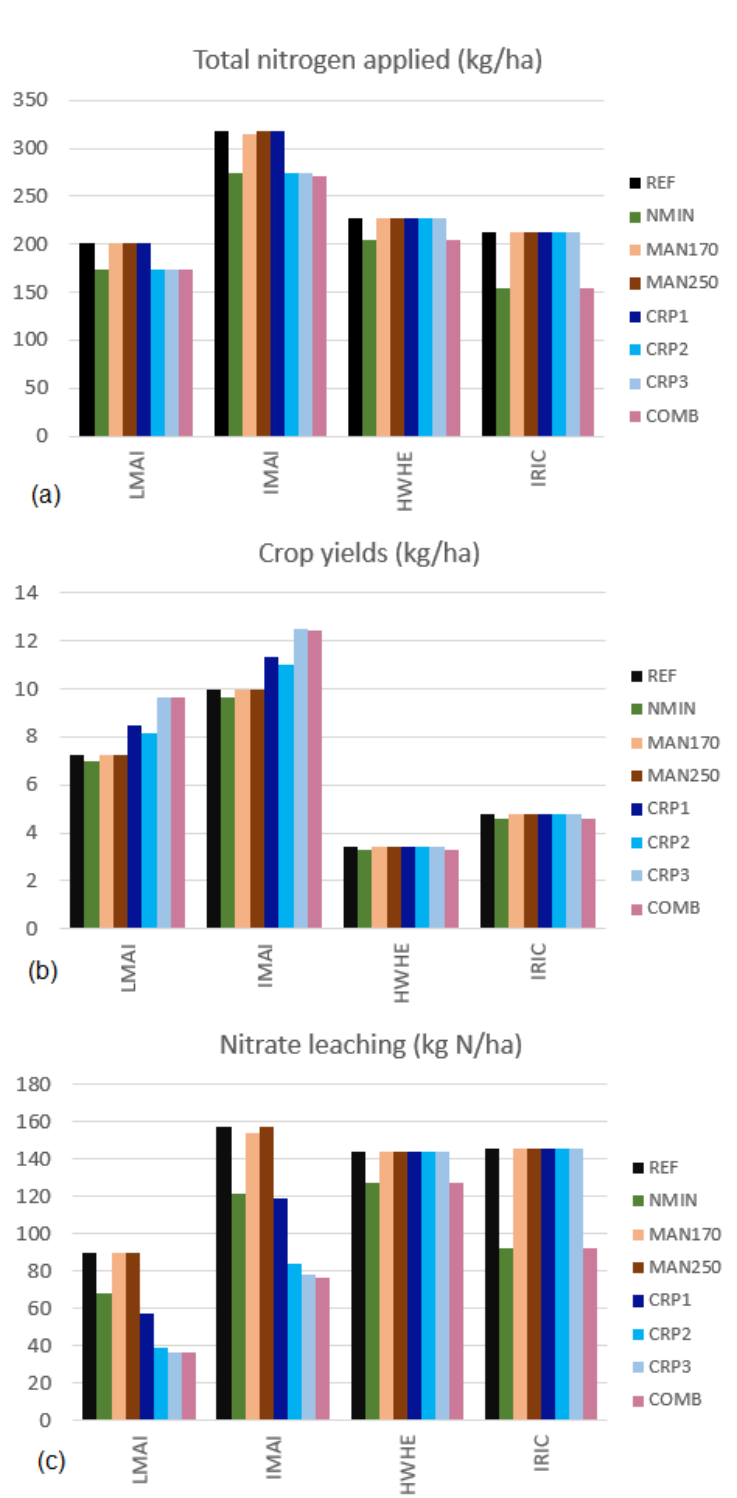
Figure 7. Changing of total nitrogen applied as fertilizer, crop yields, and nitrogen leaching for four dominant crops in the basin per scenarios (LMAI: low intensive corn, IMAI: irrigated corn, HWHE: highly intensive wheat, IRIC: irrigated rice).